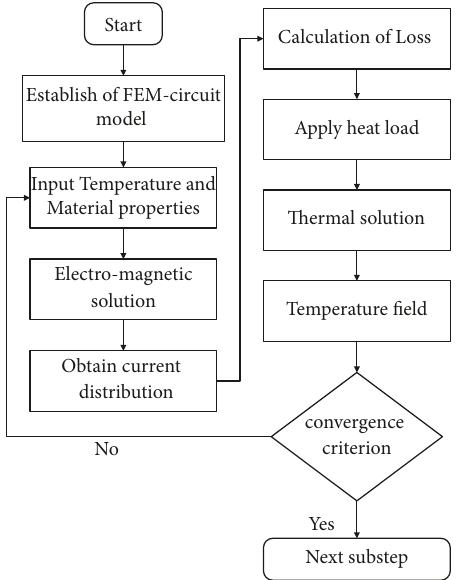
Figure 3: Cyclic iteration calculation procedure of the electromagnet-thermal analysis.